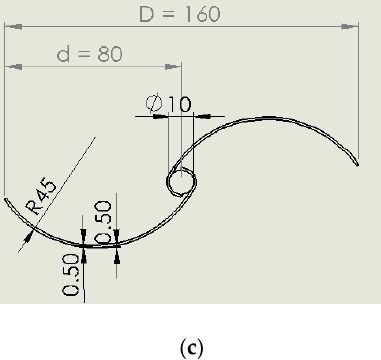
Figure 5. IceWind turbine’s three views (dimensions are in mm): ( a ) elevation, ( b ) side view, and ( c ) plan.